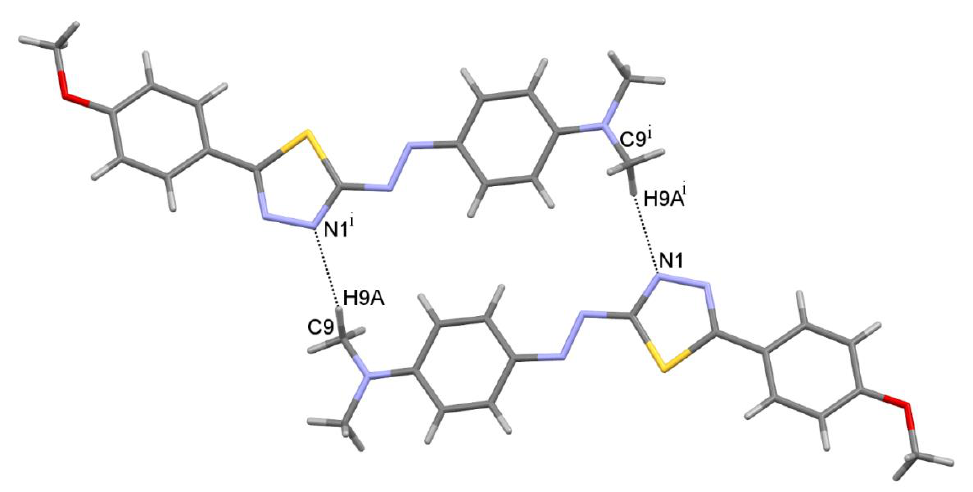
(Table 3, Table 4) and form a three-dimensional network assembled by non-covalent interactions.